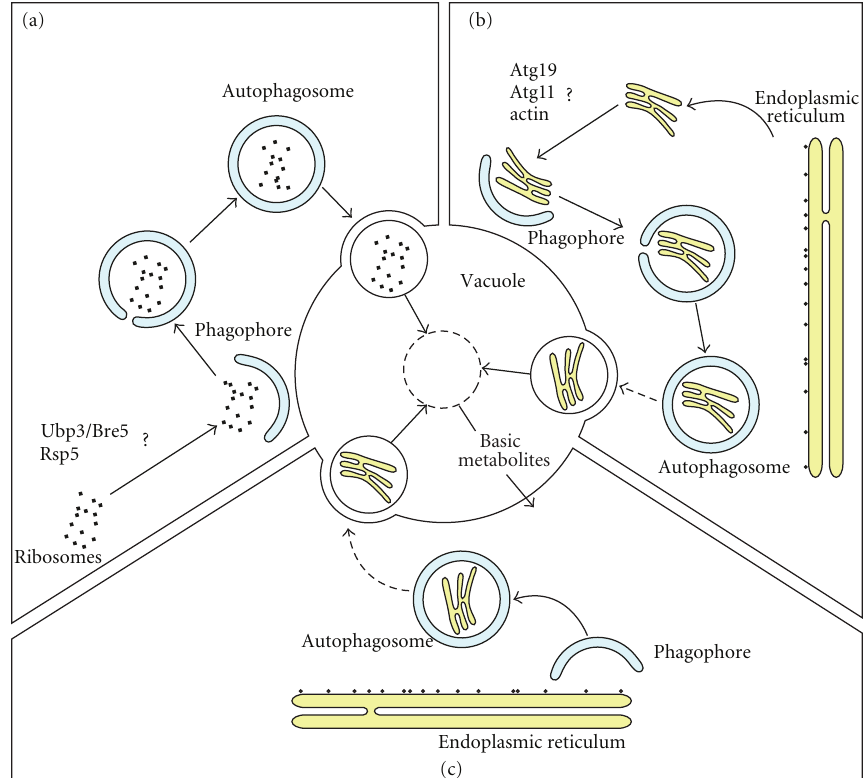
Figure 1: Mechanisms of ribophagy and reticulophagy in yeast. (a) A model for ribophagy. Under ribophagy inducing conditions, ribosomes are selectively engulfed into autophagosomes and subsequently degraded in the vacuole. The generated basic metabolites (amino acids, sugars, fatty acids etc.) are then recycled back to the cytoplasm for reuse or as a source of energy. ((b) and (c)) Models for reticulophagy. Under stress conditions, due to an accumulation of unfolded proteins and/or protein aggregates, a partial scission of the ER occurs and the formed fragments are specifically transported to the sites where autophagosome biogenesis takes place (b). ER stress triggers the recruitment of the Atg proteins onto or close to this organelle. There, possibly by utilizing the ER membranes, the Atg proteins mediate the formation of autophagosomes, which expand around the ER sections that have to be removed (c). The dashed arrows indicate that under specific ER stress conditions, autophagosomes do not fuse with the vacuole. Question marks highlight proteins that have been implicated in the transport and selection of the cargo in which the mechanism of action remains to be